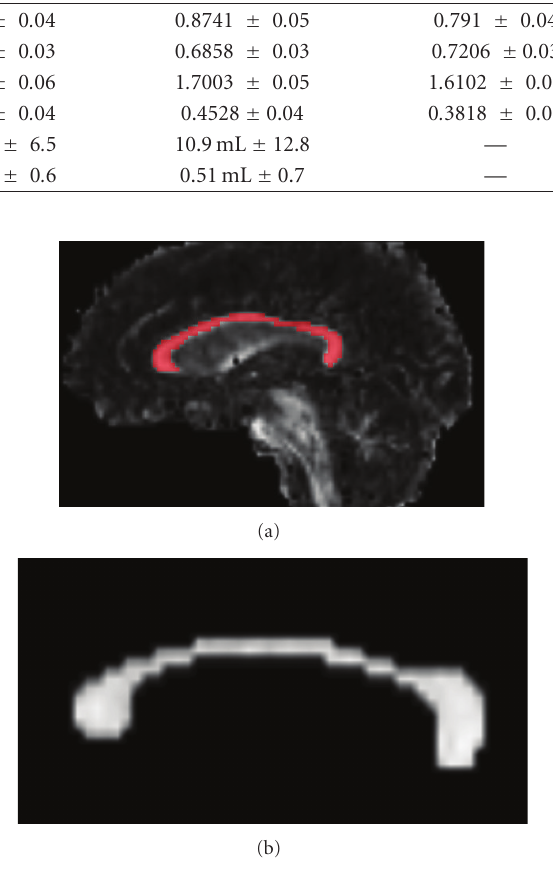
Figure 1: Sagital view of an individual FA map with the demarca- tion of the CC (a). In detail is the obtained CC mask